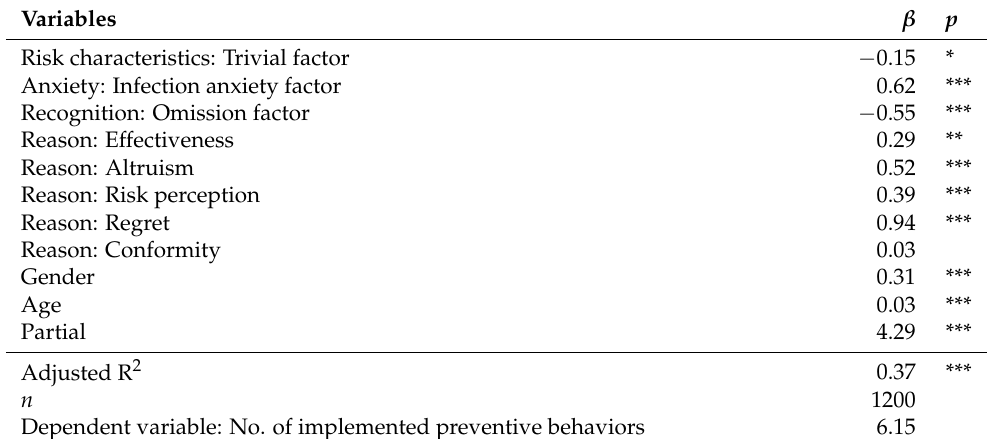
Table 5. Main factors that determine the number of implementation measures.